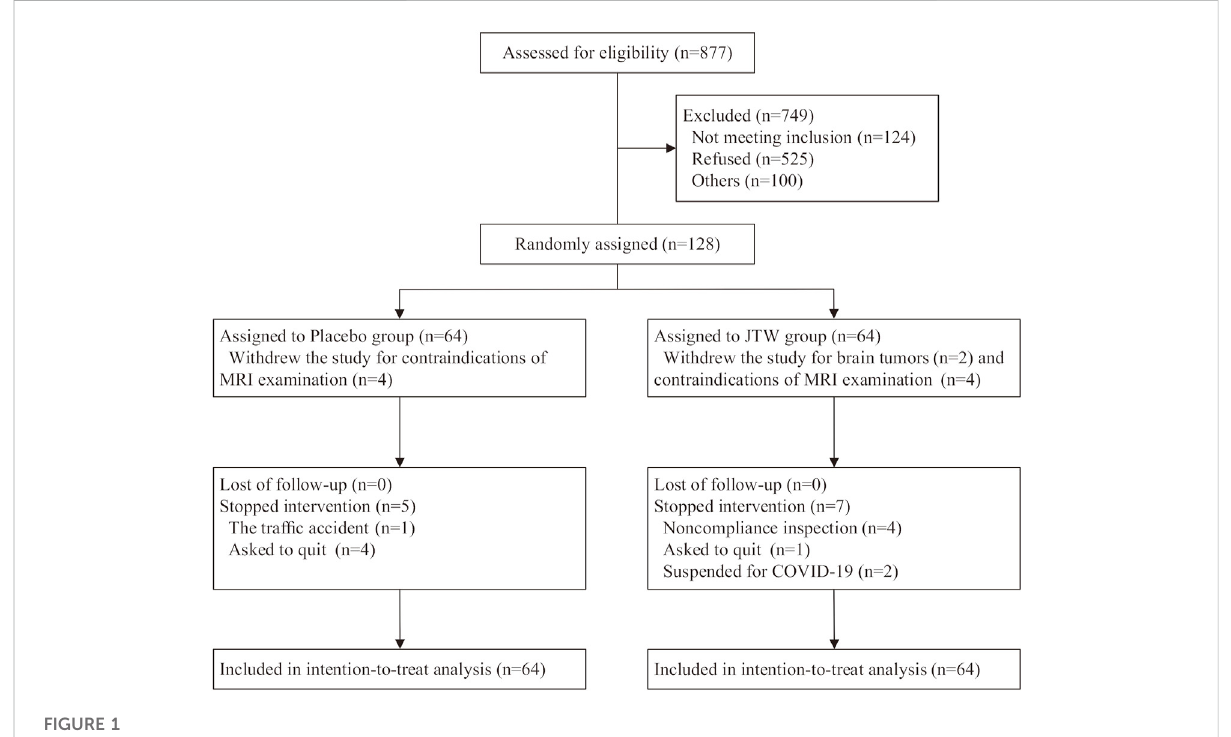
FIGURE 1 The enrollment fl ow